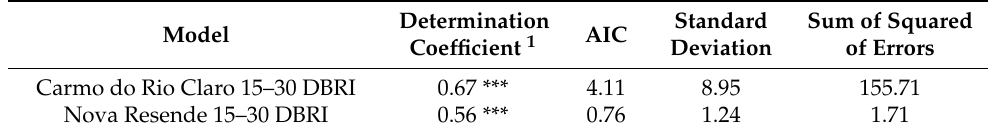
Table 5. Estimated parameters of the adjusted models for the Carmo do Rio Claro and Nova Resende municipalities, Minas Gerais state, Brazil.